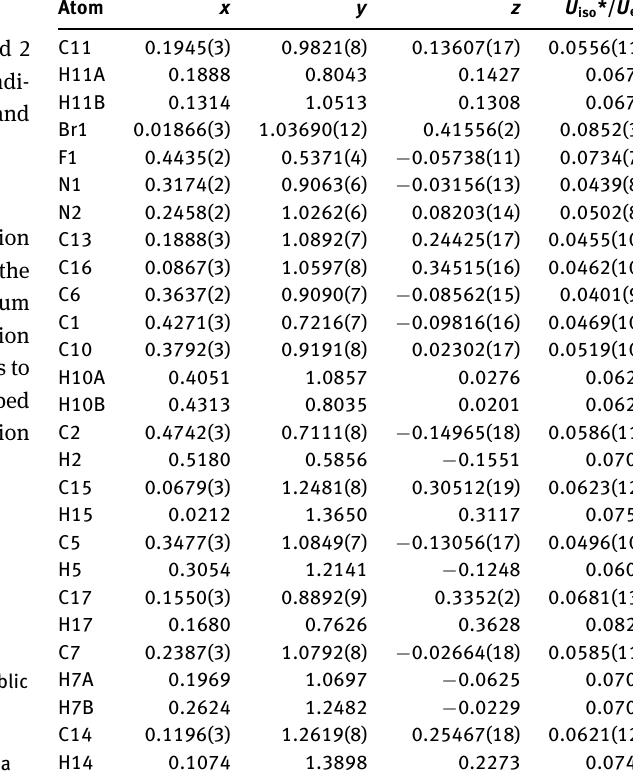
Table 2: Fractional atomic coordinates and isotropic or equivalent isotropic displacement parameters (Å 2